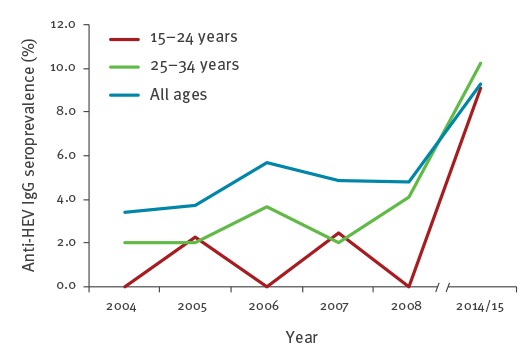
Anti-HEV seroprevalence by age in Edinburgh, Scotland 2004–2015